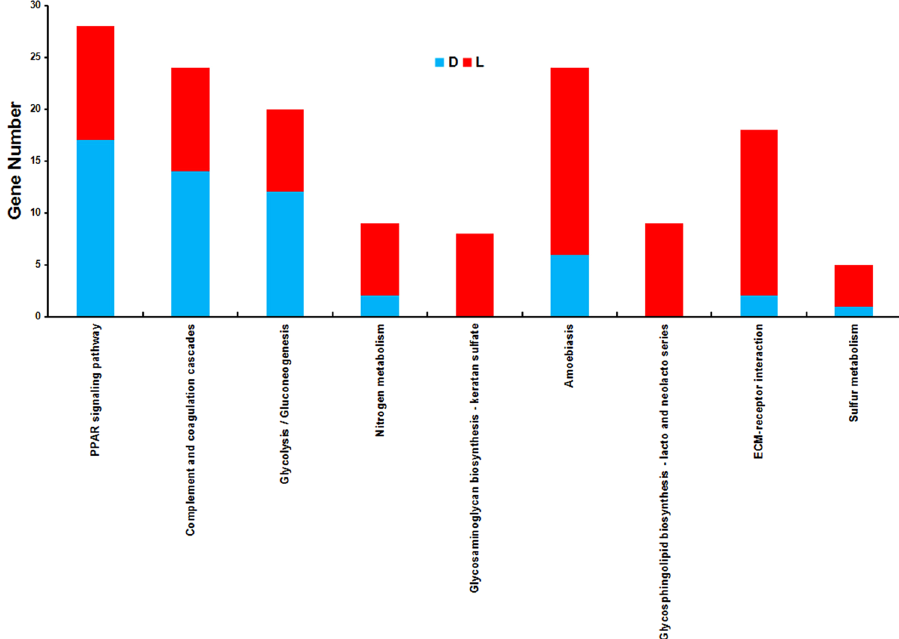
Figure 2. KEGG pathways achieved significant enrichment levels in all four enrichment analyzes. D: Duodenum higher expressed genes; L: Large intestine higher expressed